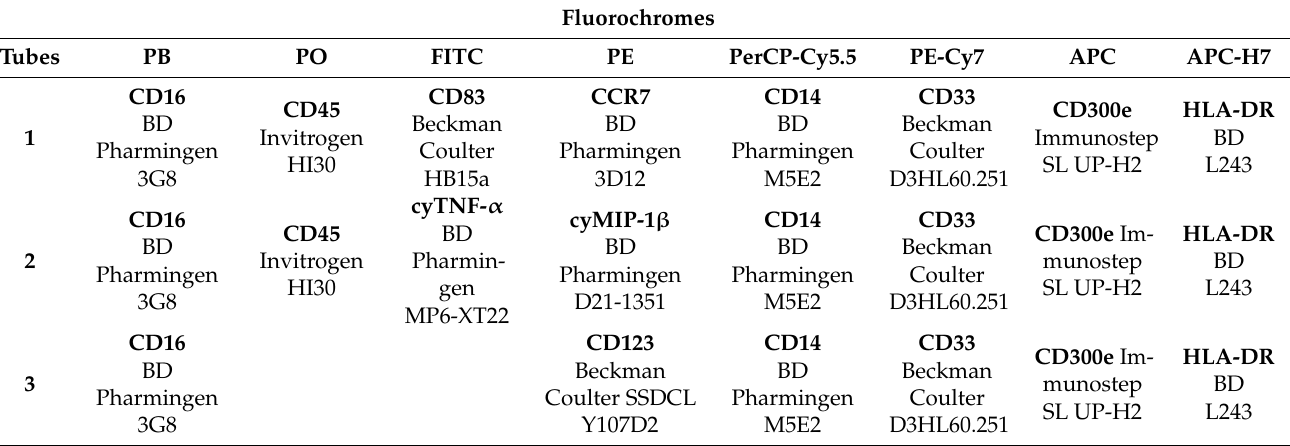
Table 1. Panel of monoclonal antibodies used for immune cells’ phenotypic characterization, indicat- ing the commercial source and